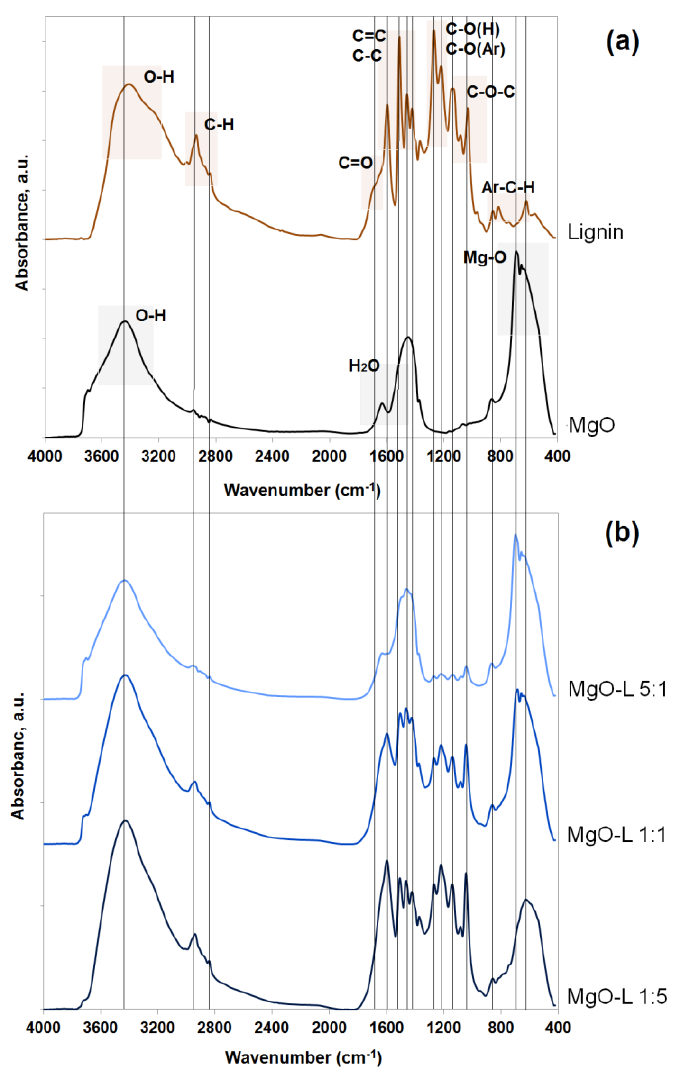
Figure 3. FTIR spectra of MgO and lignin ( a ) and MgO-lignin hybrid materials ( b ).